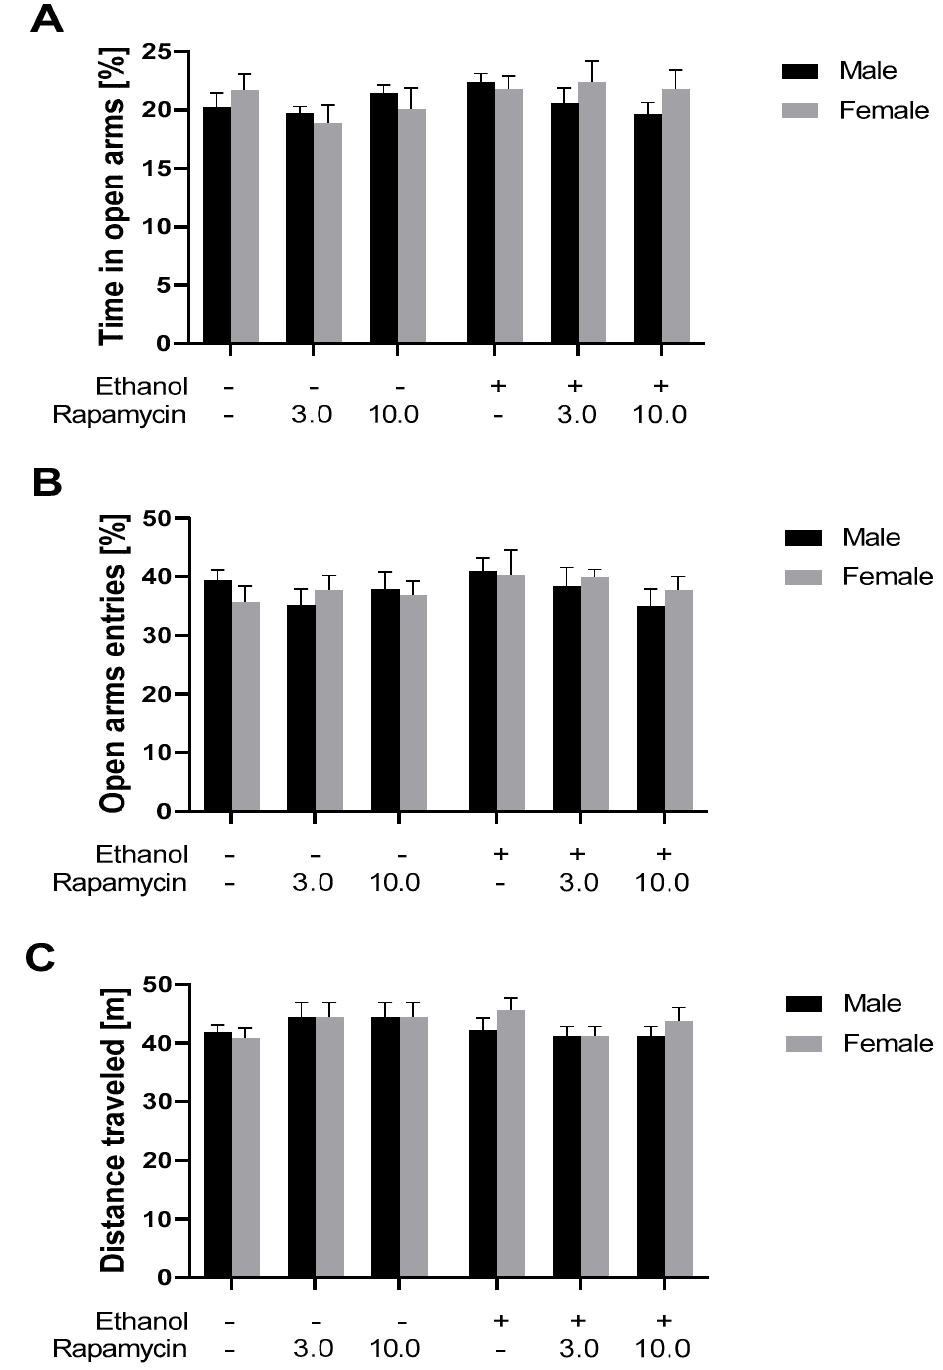
Figure 4. The influence of rapamycin pre-treatment (3 and 10 mg/kg, i.p.) during ethanol administration (PND 4-9) on anxiety-like behavior (PND 59) and locomotor activity (PND 60) in adult male and female rats measured in the elevated plus maze (EPM). ( A ) Percent of time in the open arms of the EPM apparatus; ( B ) percent of open arm entries in the EPM apparatus; ( C ) locomotion measured in the locomotor activity boxes. Results are expressed as mean ± S.E.M. of 8 subjects per group.